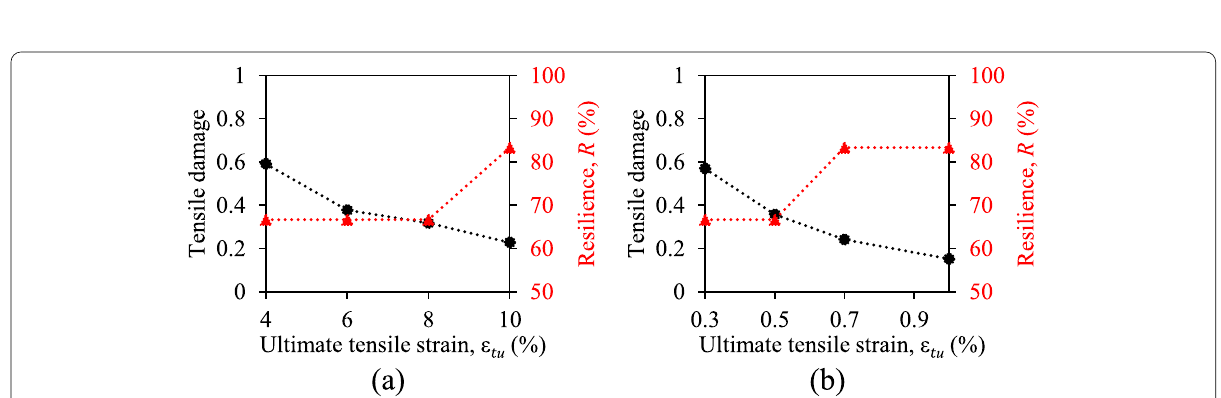
Fig. 13 The effect of the ultimate tensile strength on the maximum tensile damage and resilience: a SHCC ( σ t 0 ( σ t 0 10 MPa and ε tu 0.3%) = =